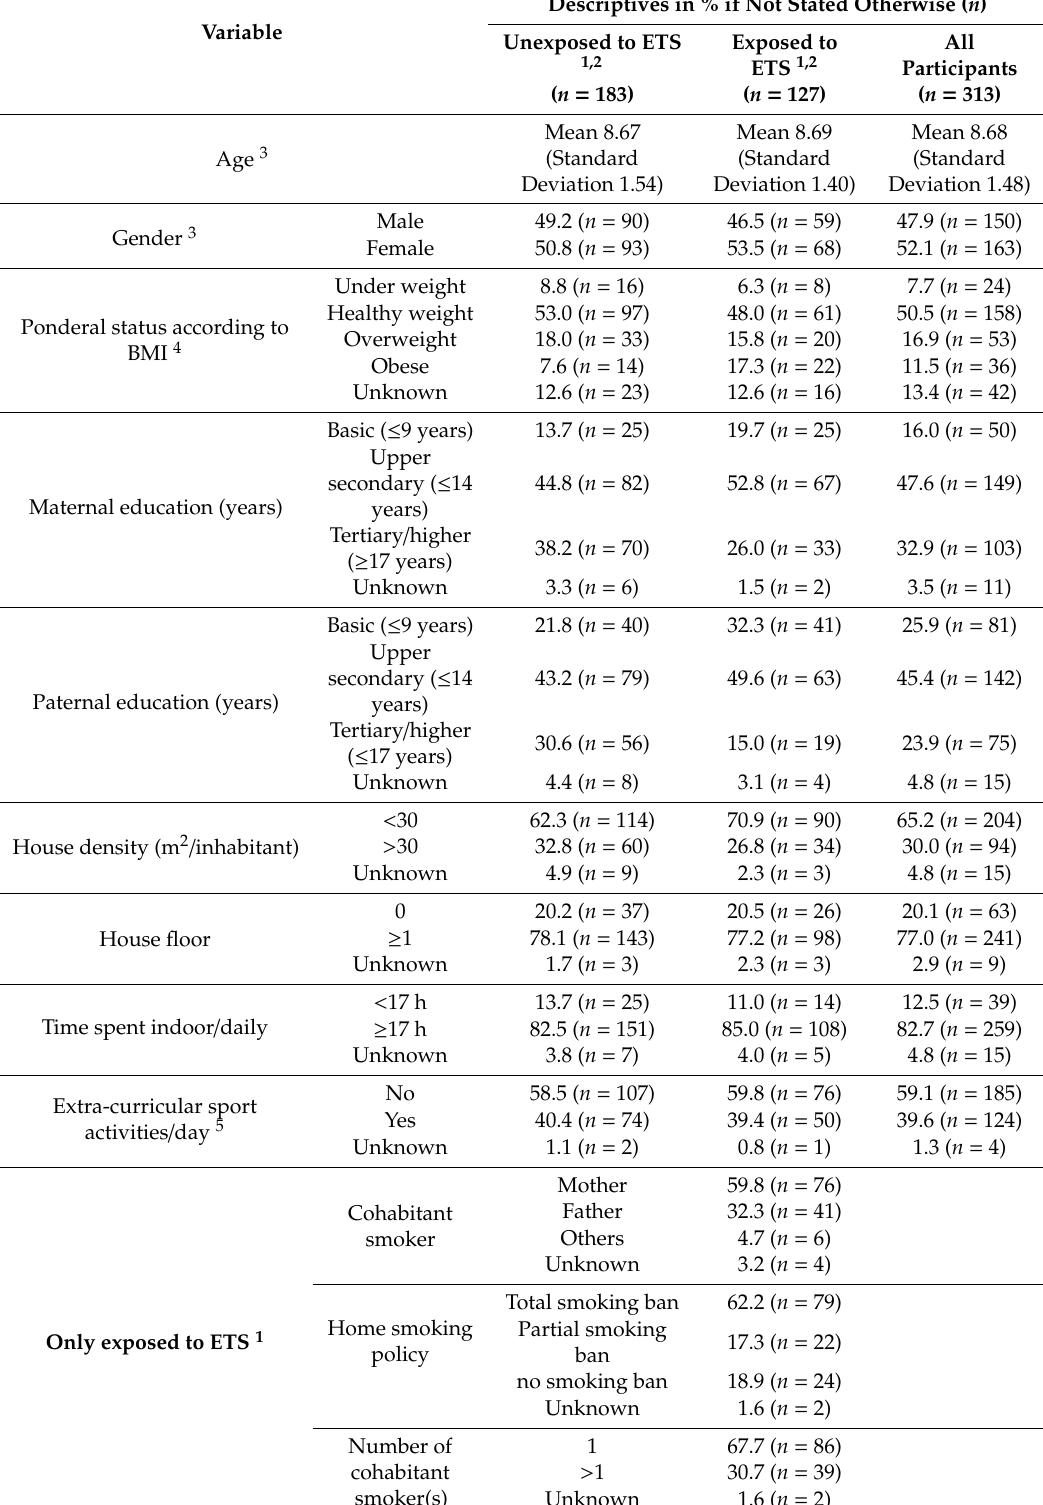
Table 1. Characteristics of the study population participating to the summer biomonitoring